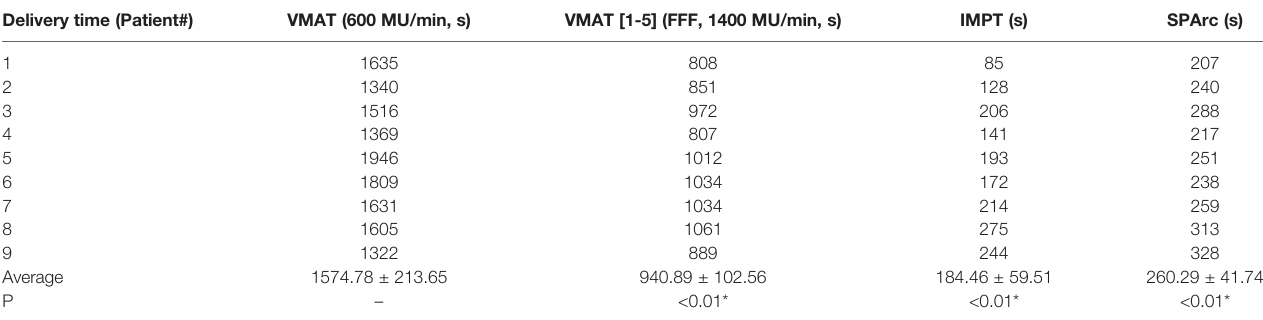
TABLE 3 | Comparison of total delivery time per patient ’ s SRS plan. Delivery time (Patient#)